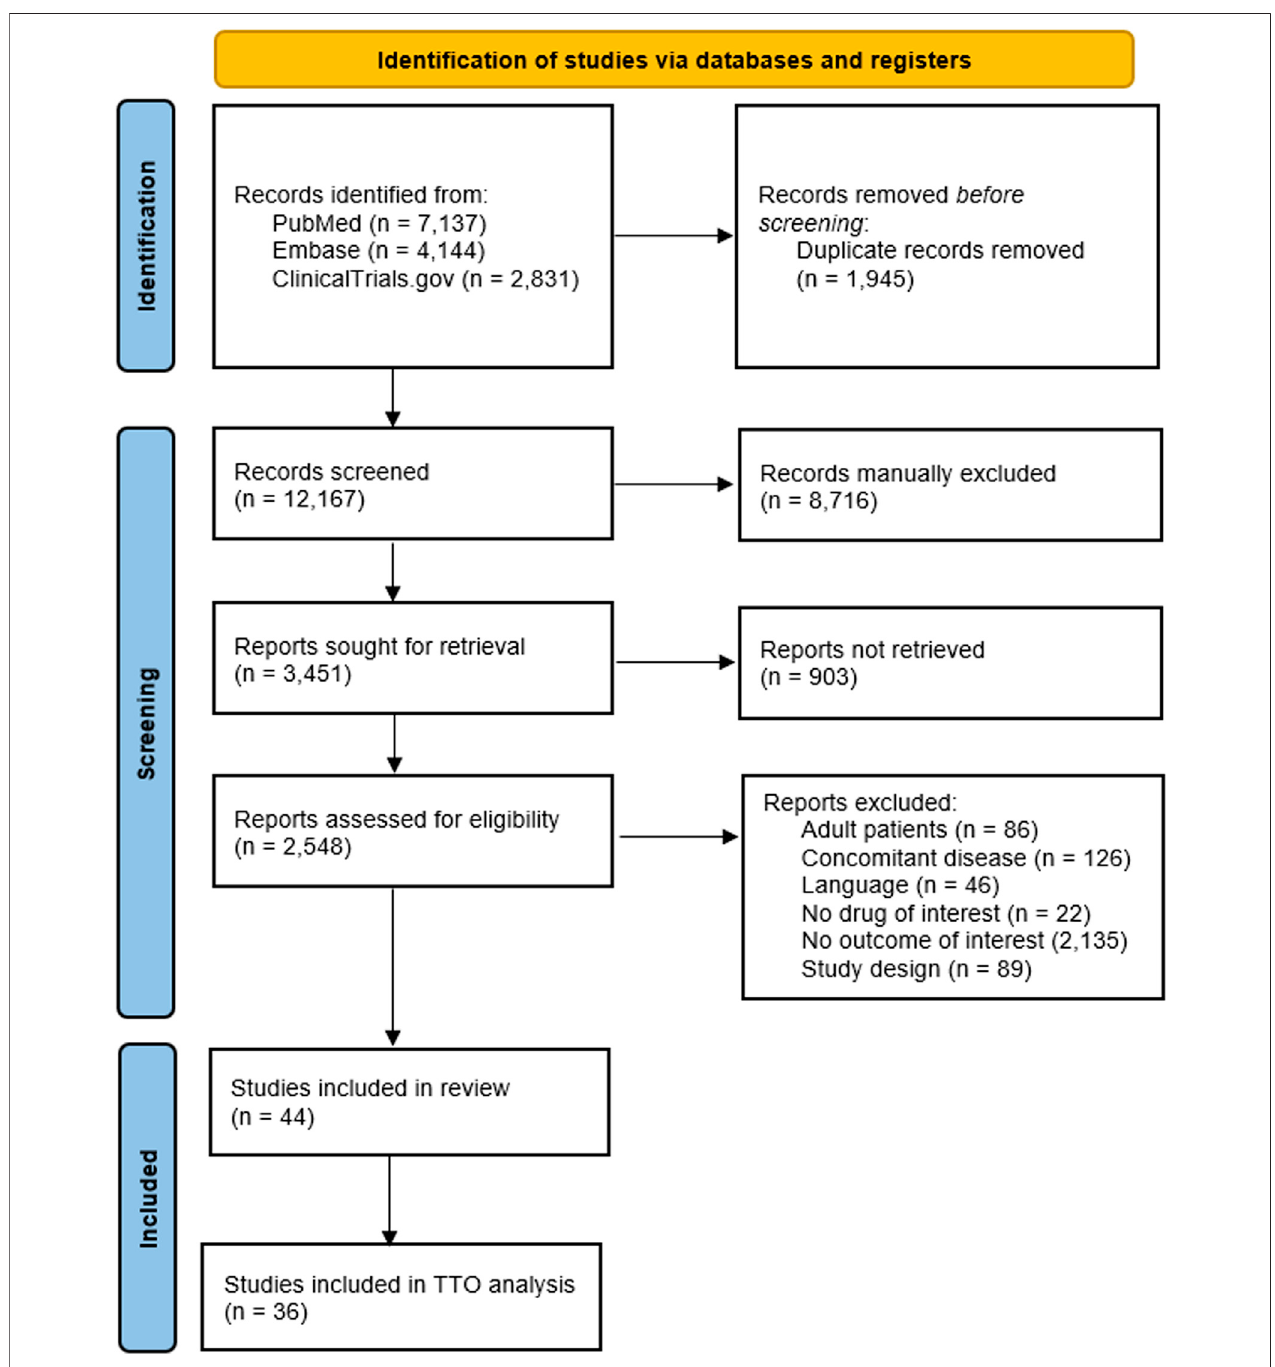
FIGURE 2 | The PRISMA fl